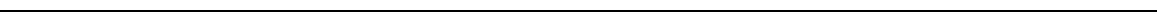
Fig. 2 Inhibition of KIF20A function inhibits the fi ssion of Rab6 transport carriers from the Golgi. GFP-RAB6, Myosin II, and KIF20A are co-localized on dotted structures that correspond to the sites of fi ssion. a HeLa cells stably expressing GFP-RAB6 were imaged by time-lapse microscopy, and images of the same cell before (t0) or 40 min (t40) after paprotrain (25 µ M) treatment are presented (Supplementary Movie 4). Paprotrain was used as an inhibitor of KIF20A function. b Quanti fi cation of the number of transport carriers and of Golgi-connected tubules in cells treated as indicated in ( a ) (mean ± SEM, n = 38 cells). *** P < 10 − 10 (Student ’ s t test). c Staining of endogenous GM130 (green), KIF20A (red), and TGN46 (blue) in HeLa cells indicates a higher co- localization of KIF20A with the trans -Golgi marker TGN46 as compared to the cis -Golgi marker GM130 (see higher magni fi cations (boxes) on the bottom). Line pro fi les of the GM130 (green), the KIF20A (red), and the TGN46 (blue) fl uorescence intensities (arbitrary units) along the white-dashed arrow. Bar, 10 µ m. d Staining of GFP-RAB6 (green), MLC-mCherry (red), and endogenous KIF20A (blue) in HeLa cells indicates a partial co-localization of the three proteins on dotted structures at the Golgi complex (see higher magni fi cations (boxes) on the bottom). Line pro fi les of the GFP-RAB6 (green), the MLC-mCherry (red), and the KIF20A (blue) fl uorescence intensities (arbitrary units) along the white-dashed arrow. Bar, 10 µ m. e Staining of GFP-RAB6 (green), MLC-mCherry (red), and endogenous KIF20A (blue) in HeLa cells treated for 45 min with paprotrain indicates a co-localization (arrow) of the three proteins at the base of a GFP-RAB6-positive tube. Bar, 10 µ